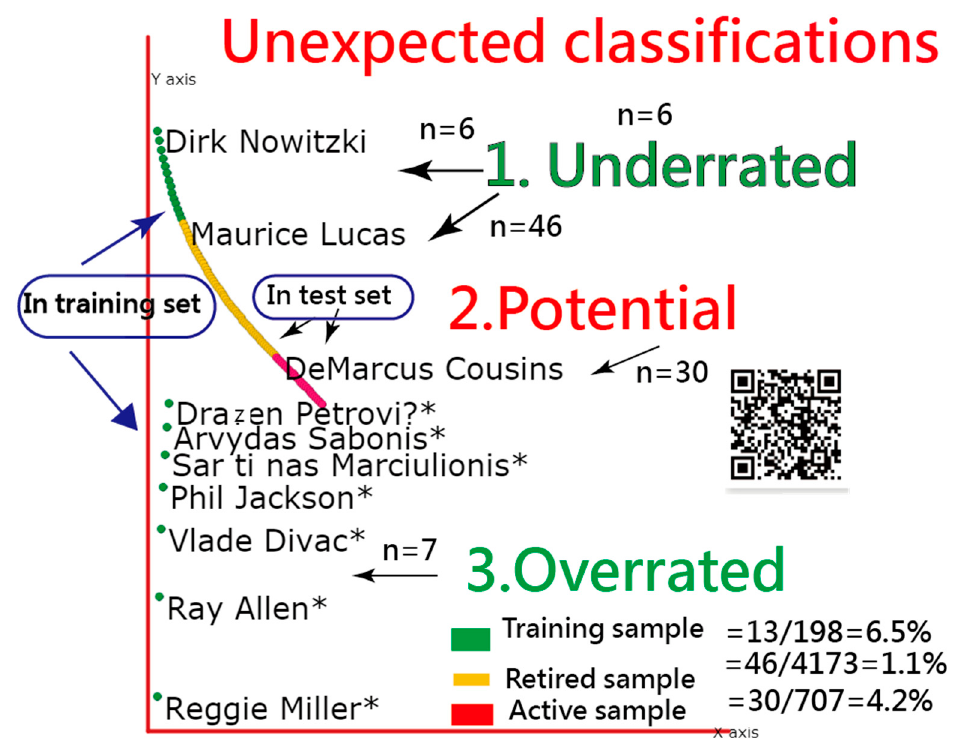
Figure 4. Unexpected findings of HOF players with underrated and overrated expectations (note: * denotes the player has been inducted into HOF).